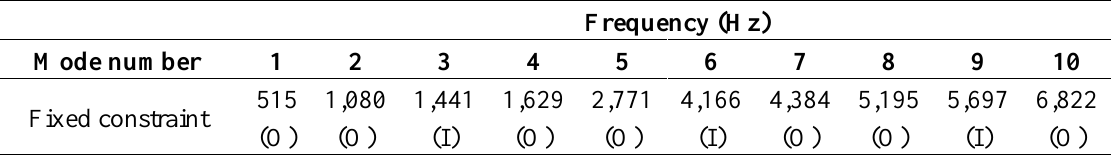
Table 2. The first ten-order natural resonant frequencies of the isolated bridge with the bridge feet clamped. O: out-of-plane vibration; I: in-plane vibration.